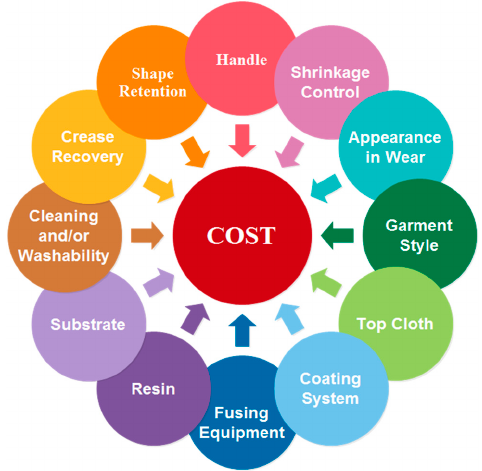
Figure 18. Factors influencing the choice of fusible interlinings.